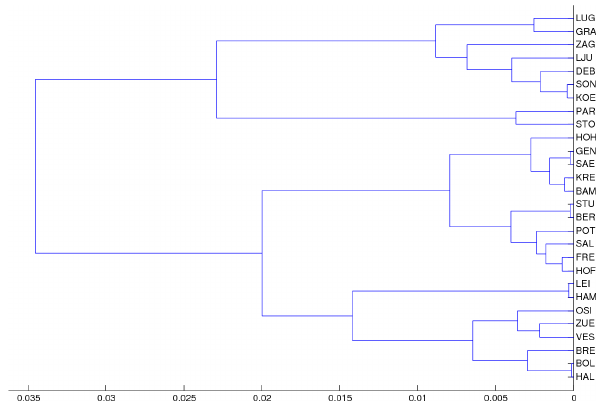
Fig. 5. Dendrogram for 5% quantile slopes.